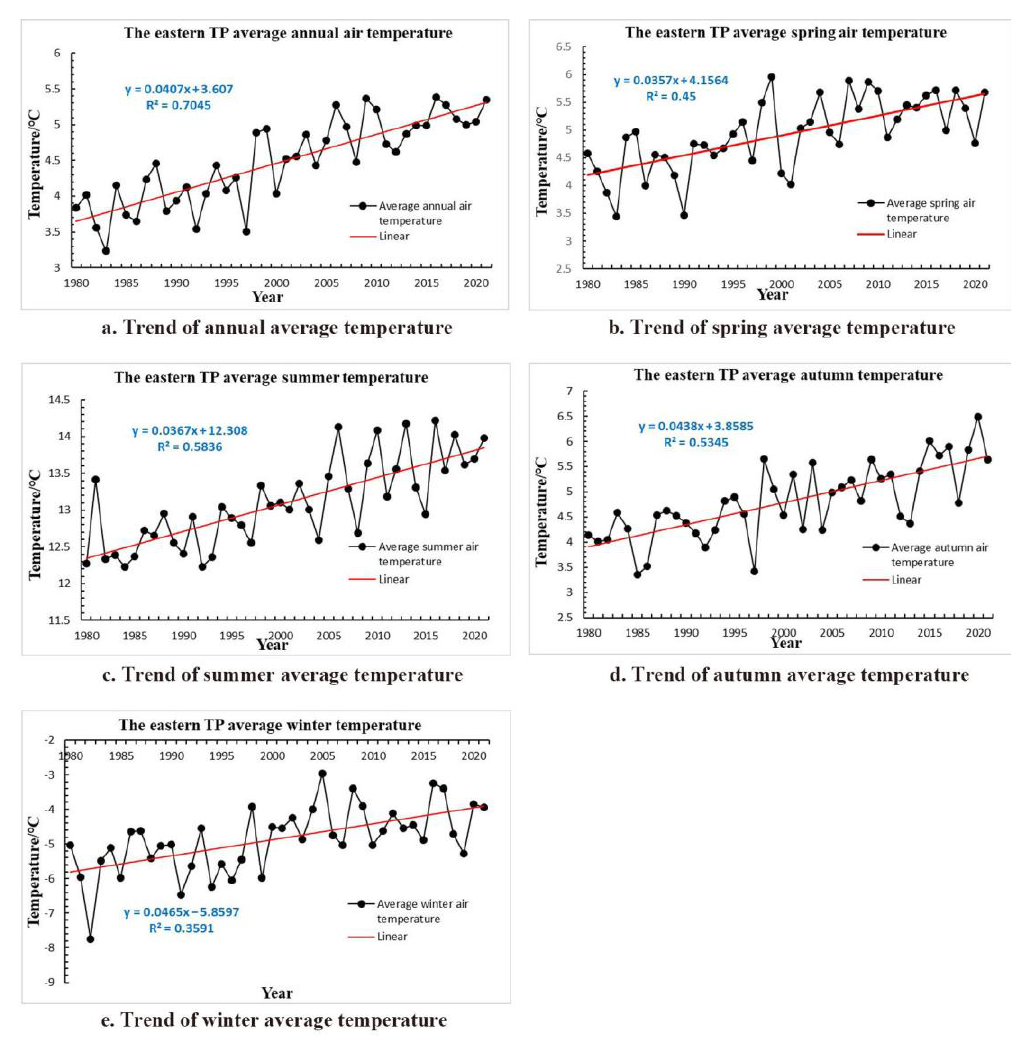
Figure 1. Trend of average air temperature over the eastern TP during 1980 – 2021 in ( a ) annum; ( b ) spring; ( c ) summer; ( d ) autumn; and ( e ) winter.